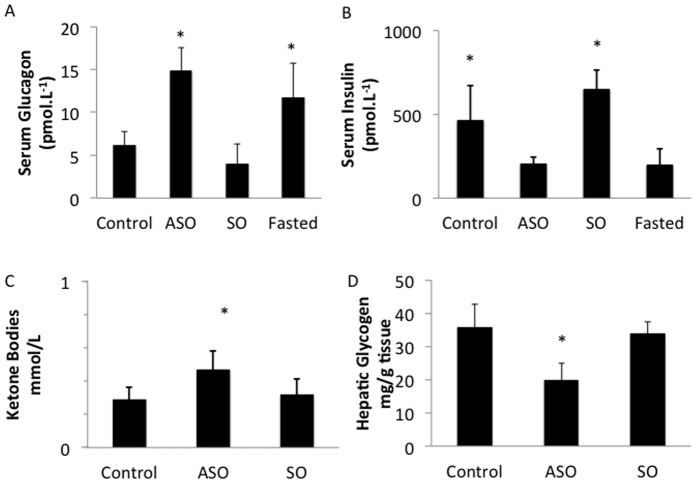
Biochemical parameters in ASO-ACC and ACC-SO mice.Serum glucagon (A) and insulin level (B), blood ketone bodies (C), and hepatic glycogen (D) in control (fed), ACC-ASO (ASO), ACC-SO (SO) and fasted rats. Data are means ± SEM of 8–10 rats. (A) *p≤0.01 to ASO and fasted vs. control and SO. (B) *p≤0.05 vs. ASO and fasted. (C and D) *p≤0.05 vs. control and SO.